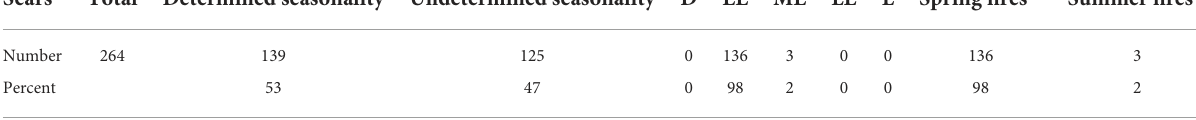
TABLE 2 Seasonality of fire scarred samples within a Pinus lumholtzii forest, in Durango,